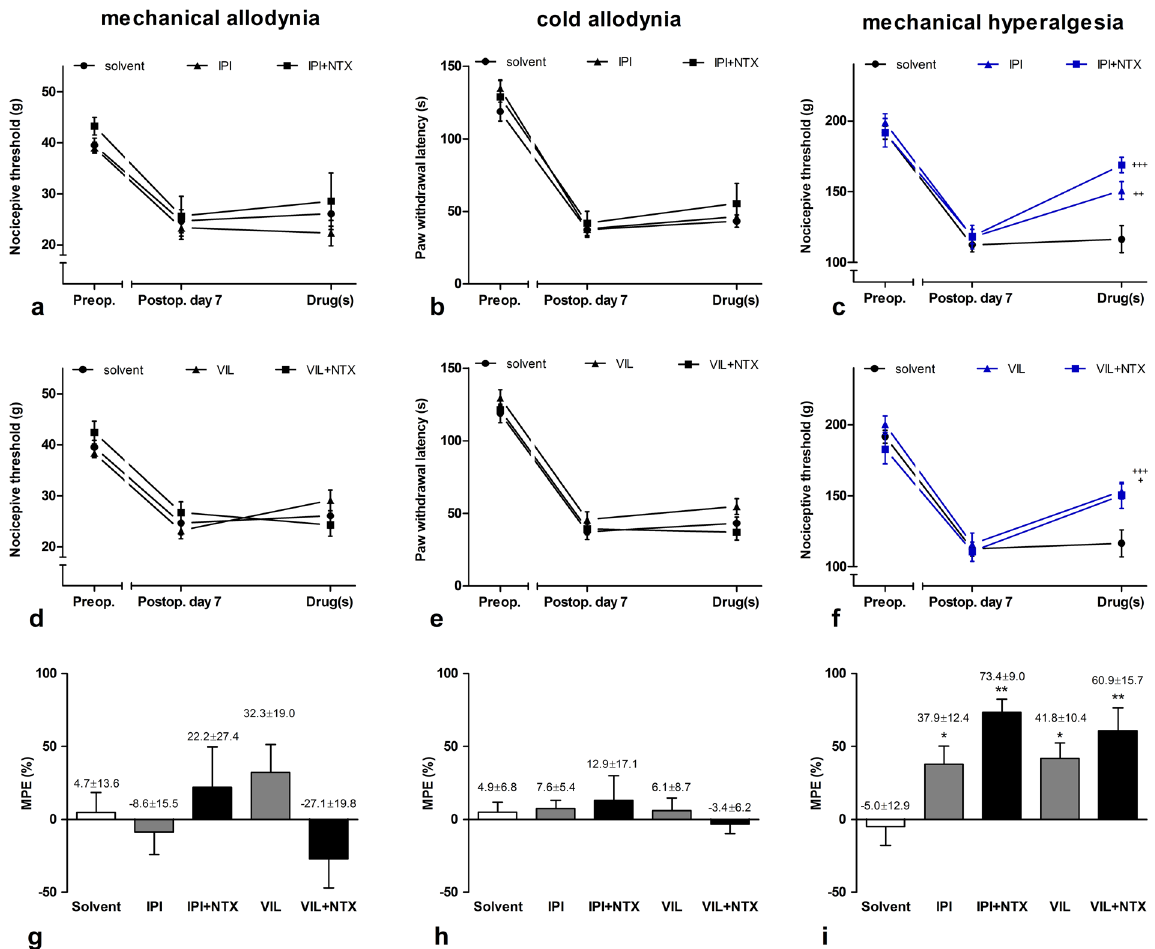
Figure 6. Antinociceptive effects of the DPP4 inhibitor IPI and vildagliptin in chronic neuropathic condition induced by partial sciatic nerve ligation. DPP4 inhibitors were ineffective in dynamic plantar aesthesiometer ( a and d ) and noxious cold sensitivity ( b and e ) tests. In Randall-Selitto test, both IPI and vildagliptin had antihyperalgesic effect which was not antagonized by NTX ( c and f ). Maximal possible effects (MPE%) of DPP4 inhibitors alone or in combination with subtype specific opioid antagonists is given on bar graphs ( g – i ). Comparisons were made with two-way ANOVA, Bonferoni post hoc test; + p < 0.05; ++ p < 0.01; +++ p < 0.001 ( a – f ) and one-way ANOVA followed by Dunnett’s post hoc test; * p < 0.1 ** p < 0.01 ( g – i ). Data on each curves and bars are given as mean and